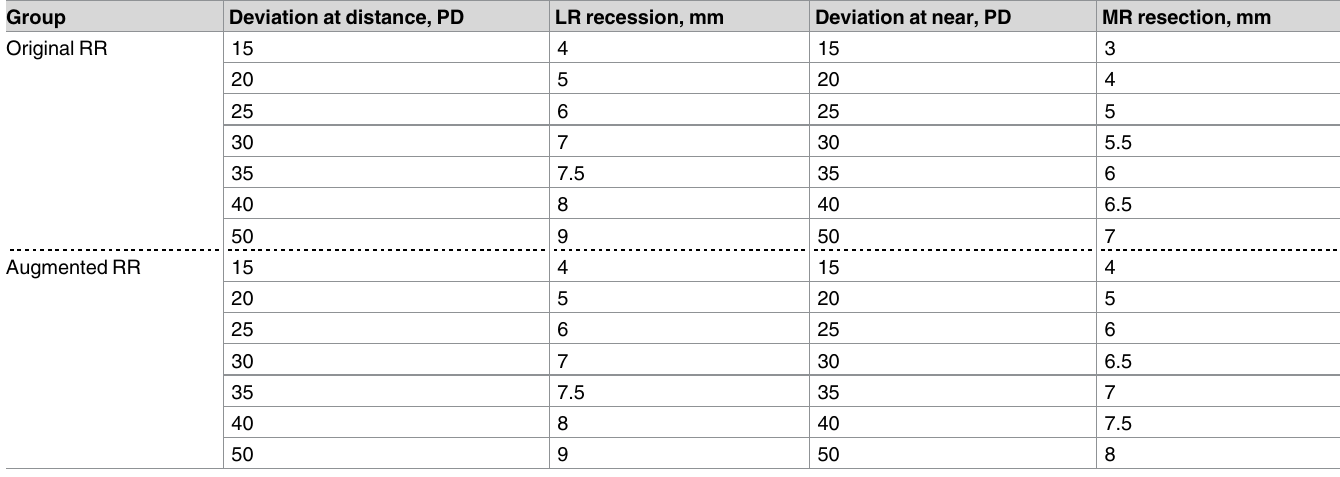
Table 1. Surgical